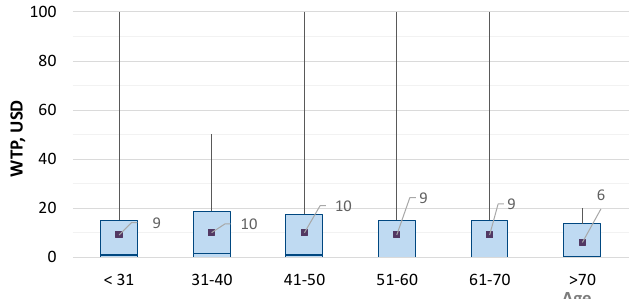
Figure 10. Box-plots for the correlation between WTP and the age class of the respondents (the bullet represents the average value for each category).